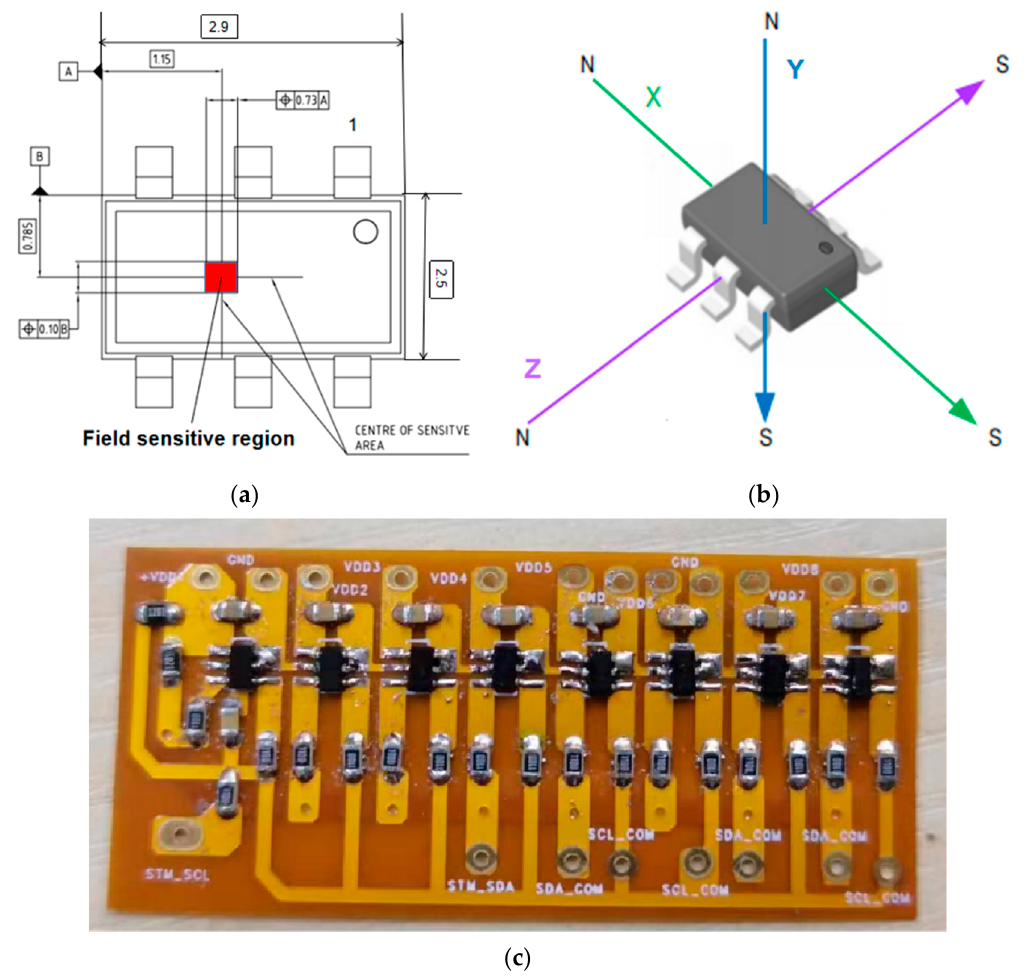
Figure 2. 3D magnetic sensor. ( a ) Three-dimensional magnetic sensor size diagram; ( b ) 3D magnetic sensor physical picture; ( c ) Three-dimensional magnetic sensor array.